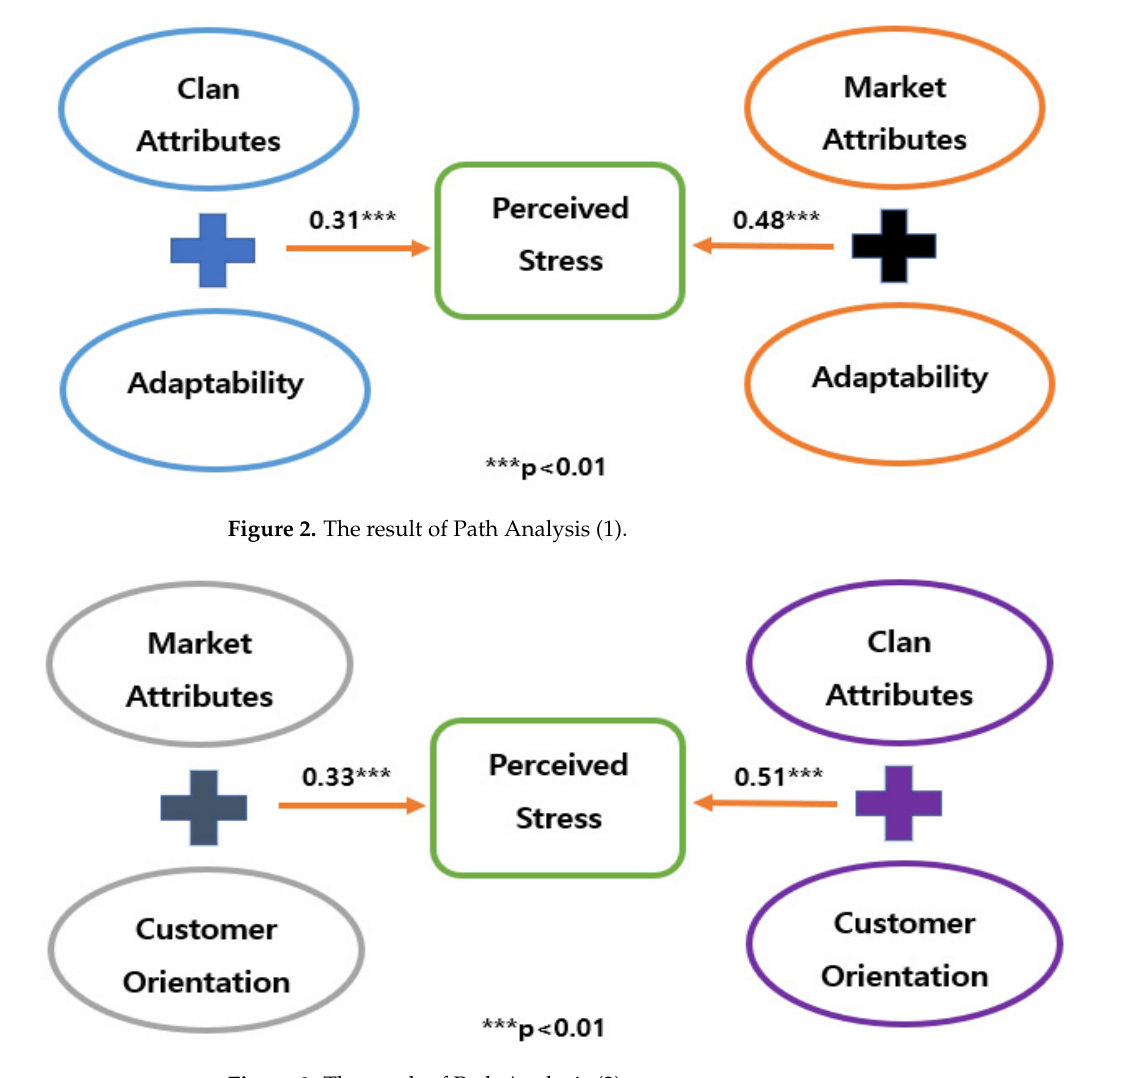
Figure 3. The result of Path Analysis